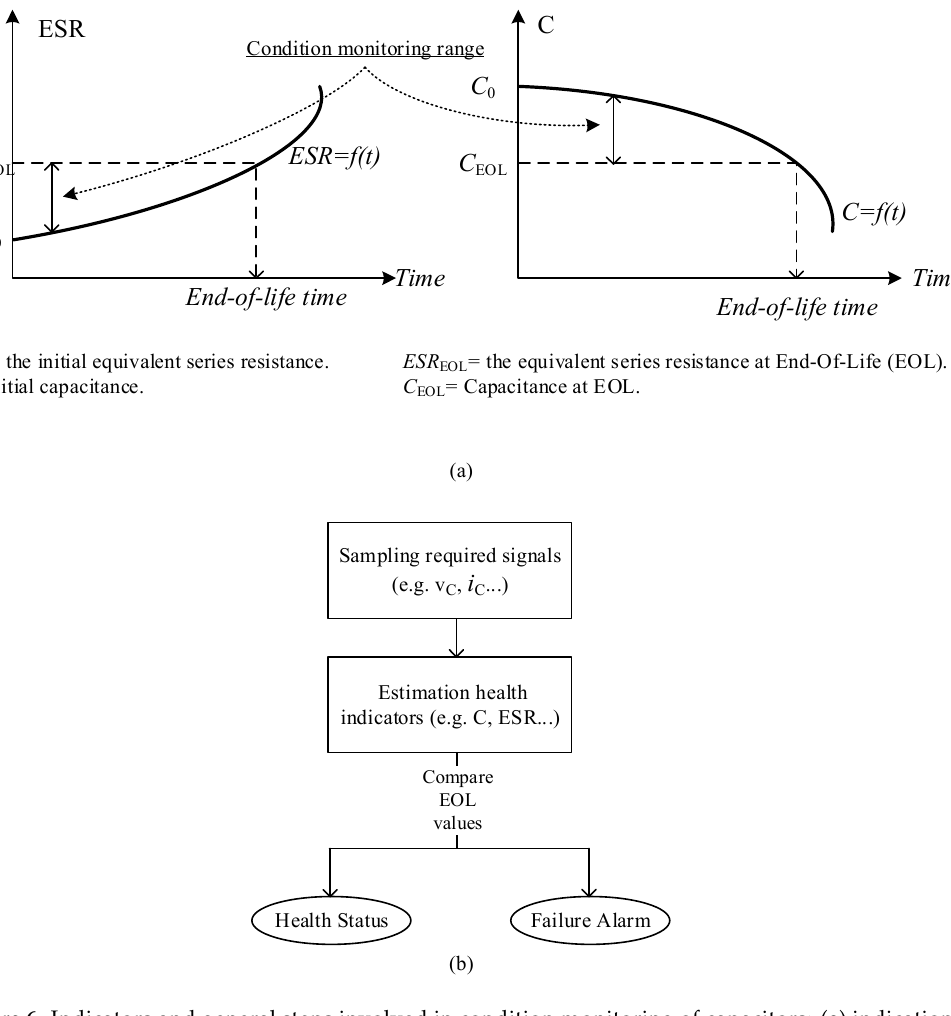
Figure 6. Indicators and general steps involved in condition monitoring of capacitors: ( a ) indication curves of capacitor degradation and ( b ) general steps of condition monitoring for capacitors.